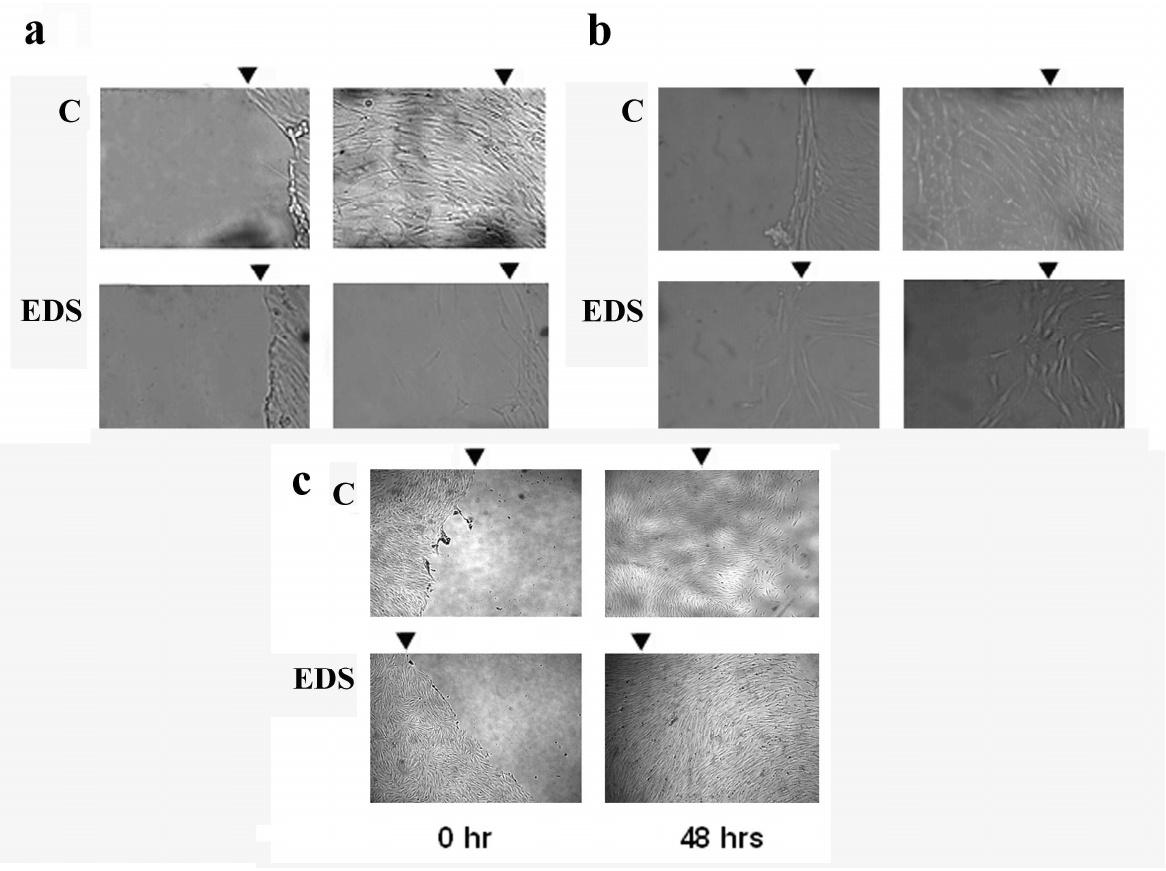
FIGURE 1. Wound healing and migration in EDS fibroblasts . (a) Fibroblasts of control and Classical EDS patients were scraped ( 0 h ) and allowed to migrate for 48 h ( 48 h ). (b) Fibroblasts were scraped as above and allowed to migrate in the presence of IGFBP-1. (c) Fibroblasts were grown in medium supplemented with type V collagen. After wounding, fibroblasts were allowed to migrate in the same supplemented medium. Arrowheads indicate the wound